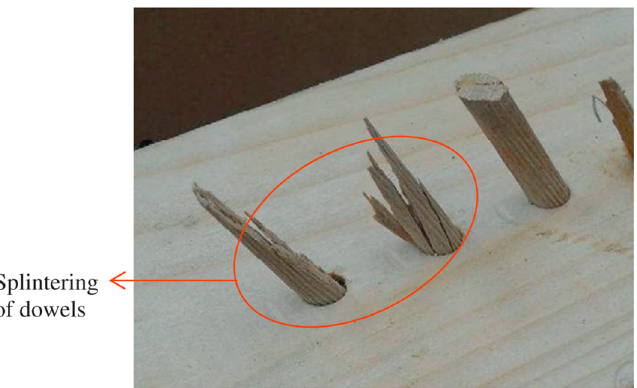
Figure 7. Splintering of beech dowels ( Φ = 10 mm, length = 200 mm) in rotary welding of a 152 mm thick beam of spruce [66].